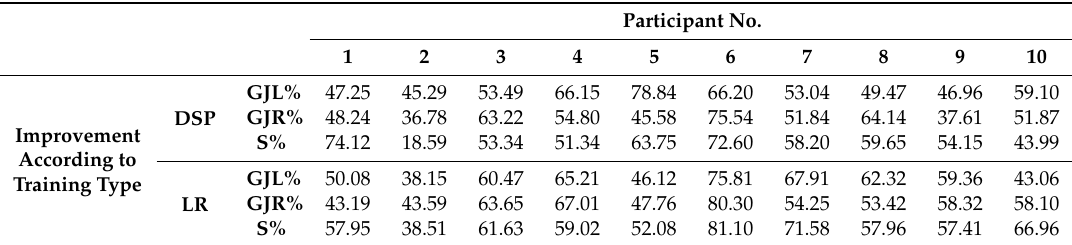
Table 8. Improvement Rates Achieved at the End of System Usage Process. GJL% means glenohumeral left joint % improvement; GJR% means glenohumeral right joint % improvement; S% means spine % improvement.